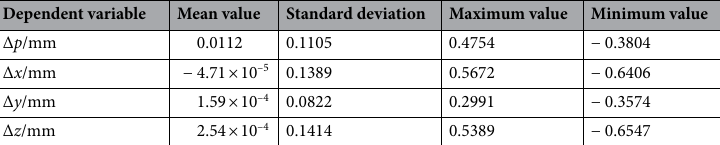
Table 3. Numerical characteristics of terminal position error of the tool-changing